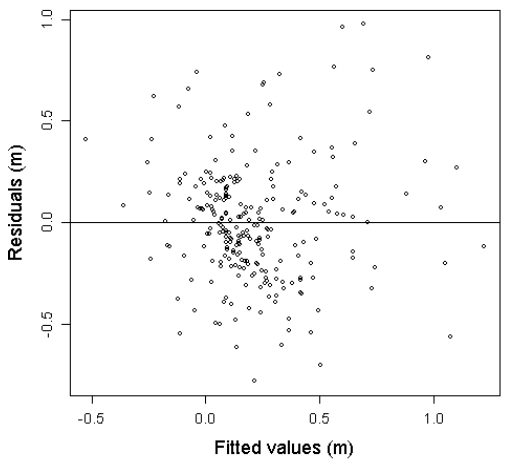
Figure 5. Residual graph for the height change model Equation (1).